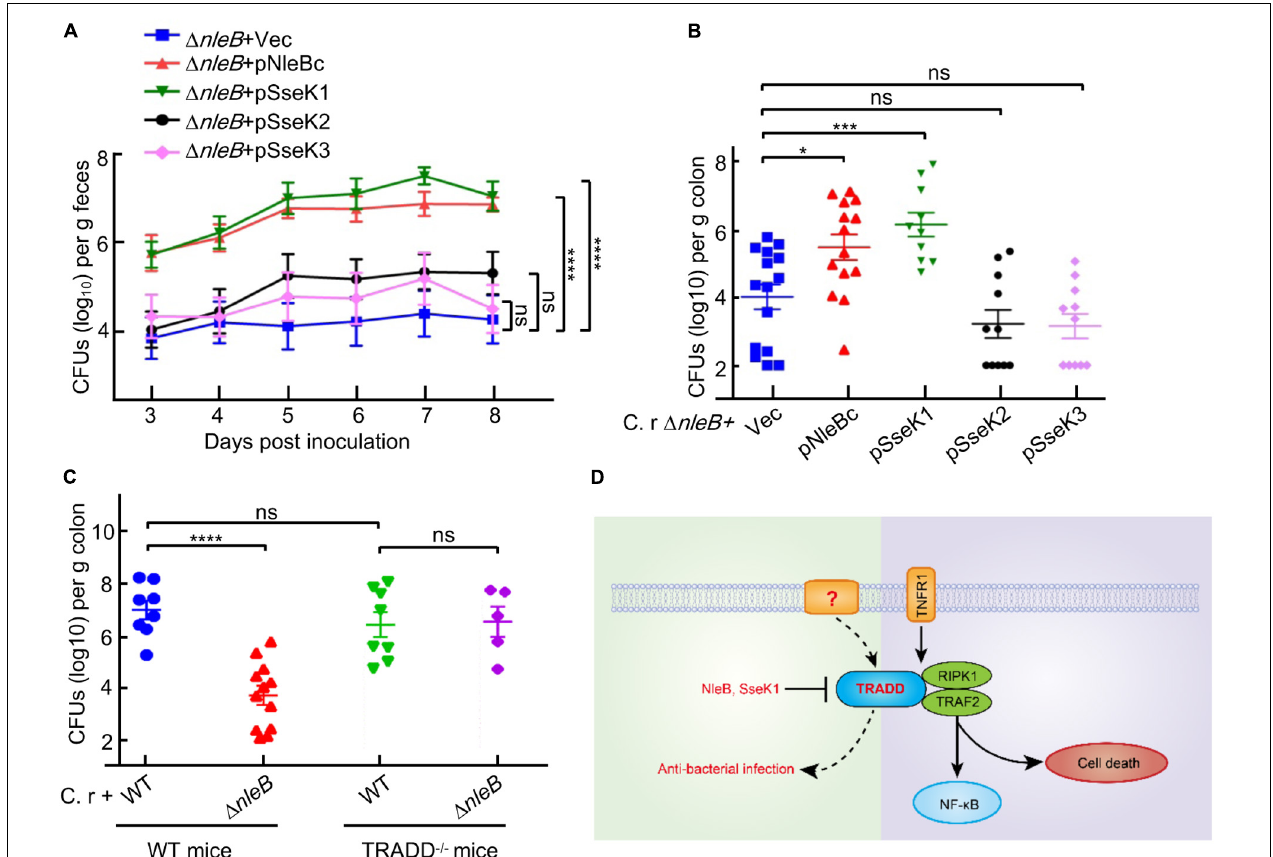
FIGURE 5 | Only SseK1 fully rescues the bacterial colonization contributed by NleBc in C. rodentium infection animal model. (A,B) 5–6 week-old C57BL/6 male mice were orally gavaged with the indicated C. rodentium derivatives. The viable stool bacteria count (log10 CFU/g feces) (A) and bacterial colonization in the colon (log10 CFU/g colon, n > 6) 8 days post-infection (B) were presented as mean ± s.e.m. pNleB(c), pSseK1, pSseK2, and pSseK3 are complementary plasmids expressing NleB(c), SseK1, SseK2, and SseK3, respectively. (C) 5–6 week-old TRADD − / − mice and parent mice were orally gavaged with wild type C. rodentium and nleB deletion mutant. Bacterial colonization in the colon (log10 CFU/g colon, n > 6) 8 days post-infection were presented. * P < 0.05, *** P < 0.001, and **** P < 0.0001 (one-way ANOVA), ns, not statistically significant. Data in (A–C) are representative from at least three repetitions. (D) Schematic diagram of TRADD-mediated